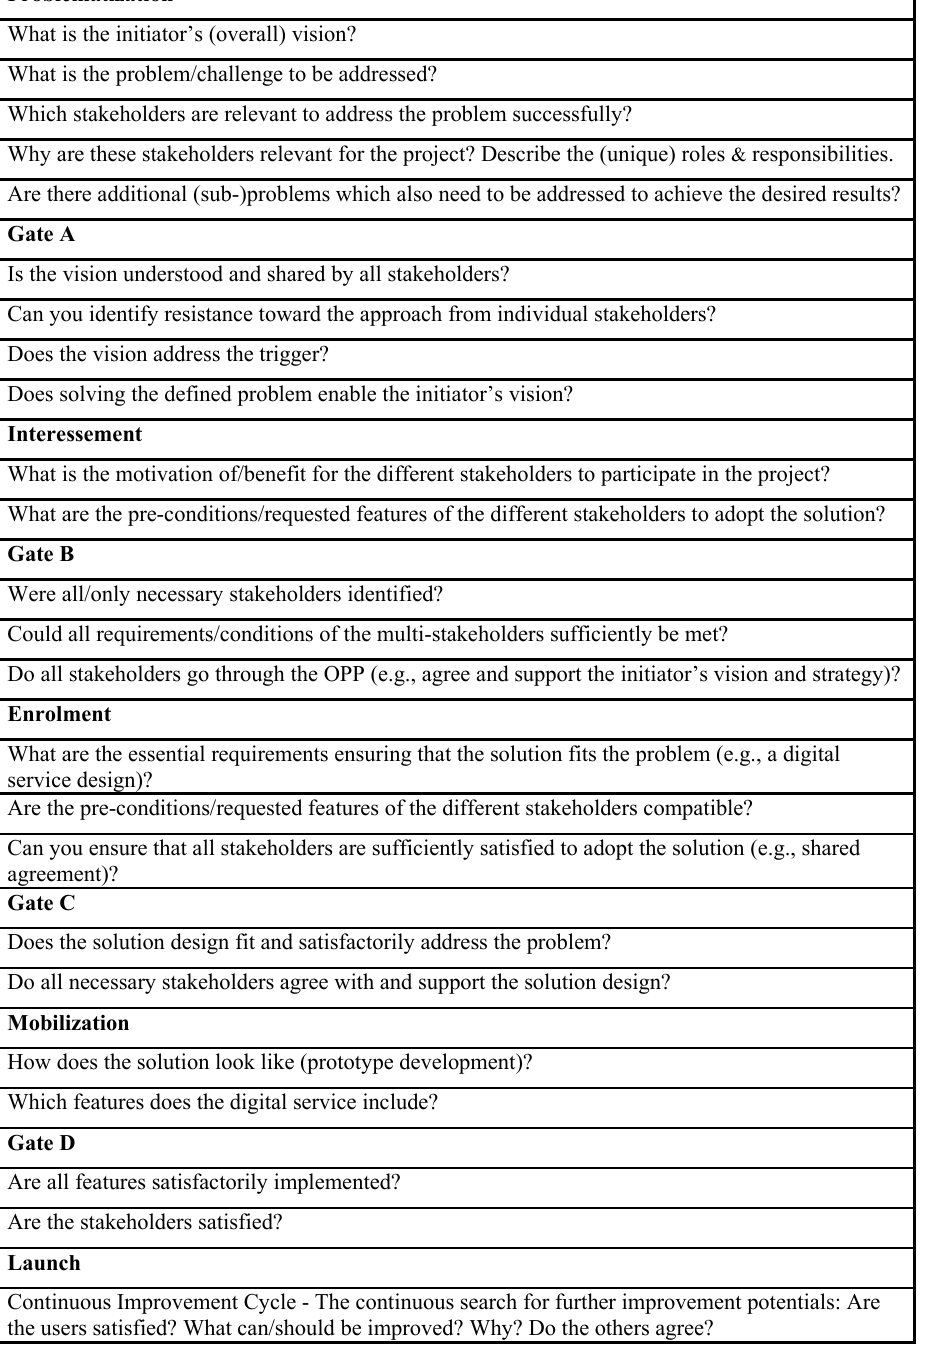
Table 1. Stakeholder Onboarding Model – Guiding Questions